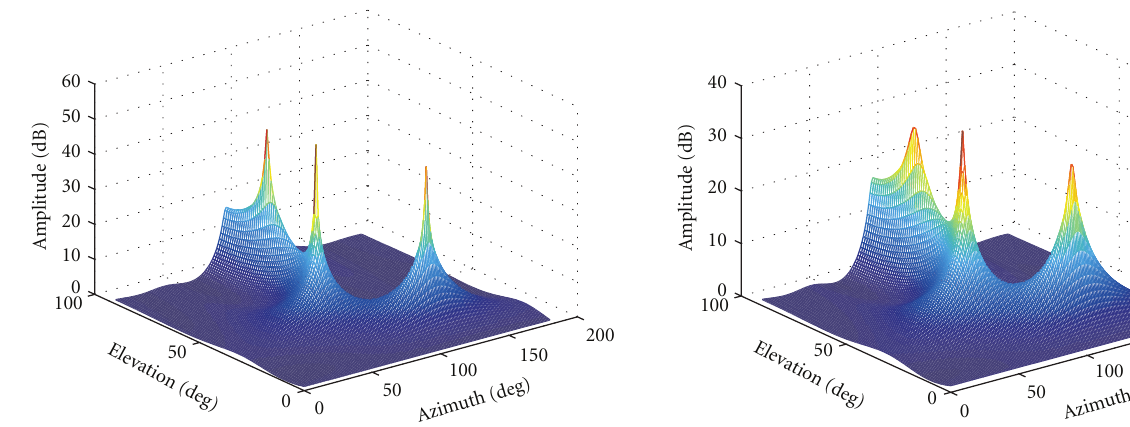
Figure 7: MUSIC pseudospectrum after the proposed compensa- tion.